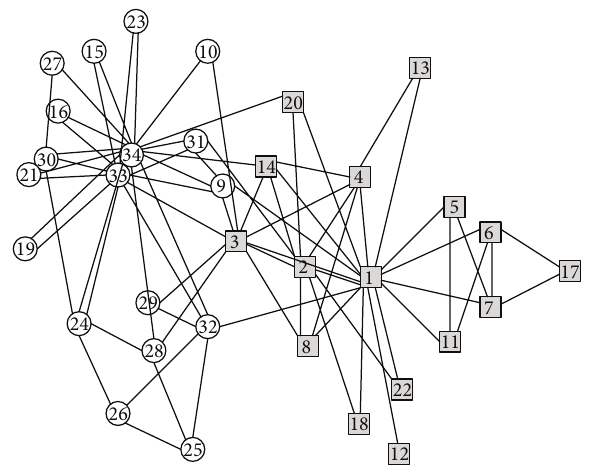
Figure 3: The community structure in Karate club